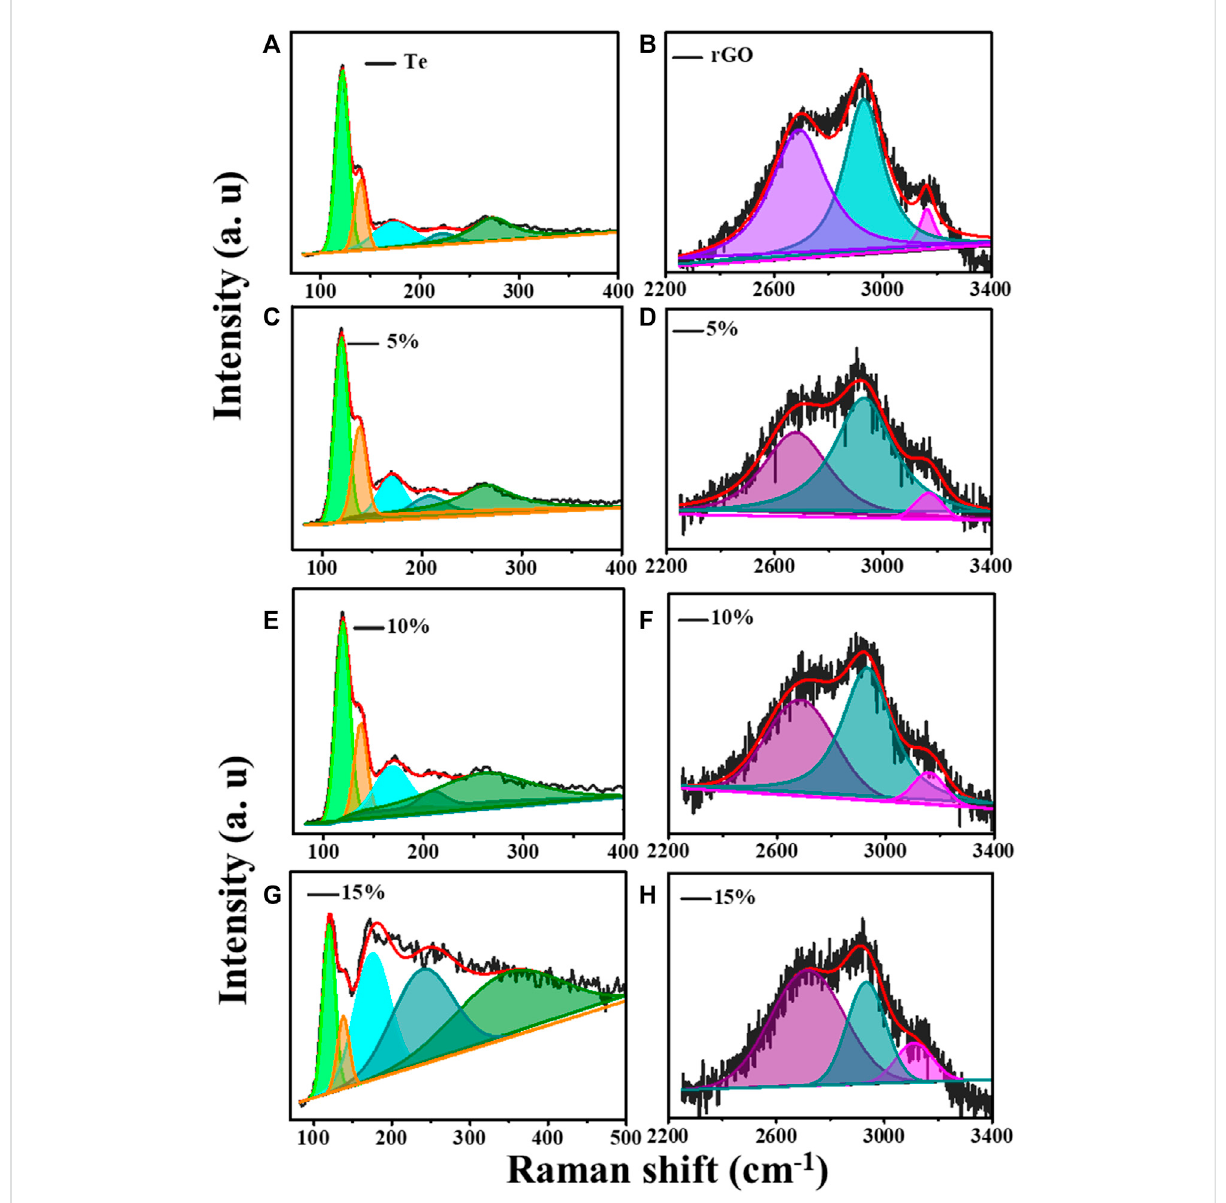
FIGURE 2 Raman deconvolution in two regions for (A) Te tubes, (B) rGO, (C) and (D) for TG1, (E) and (F) for TG2, (G) and (H) for